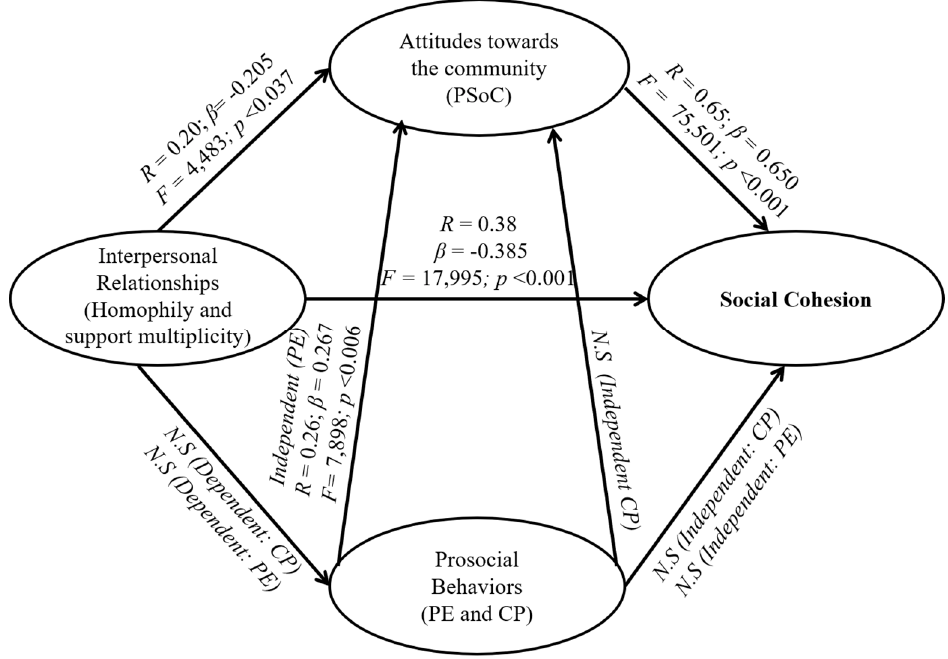
Figure 3. Theoretical model of the constitutive elements of social cohesion indicating the results of the regression coefficients.